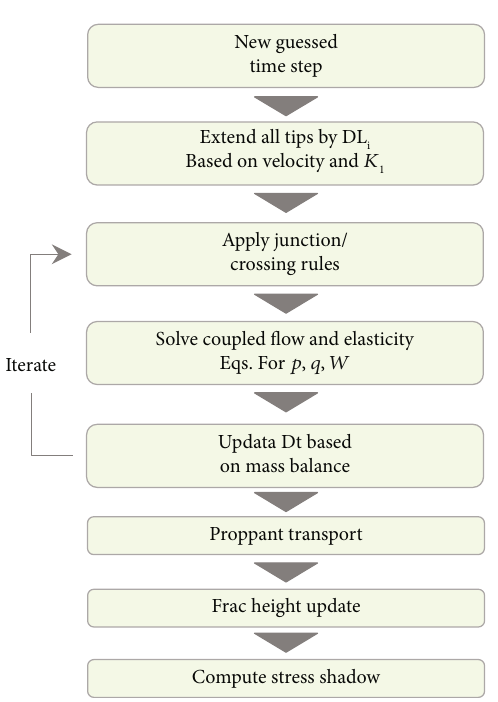
Figure 3: Basic work fl ow of the UFM [6].